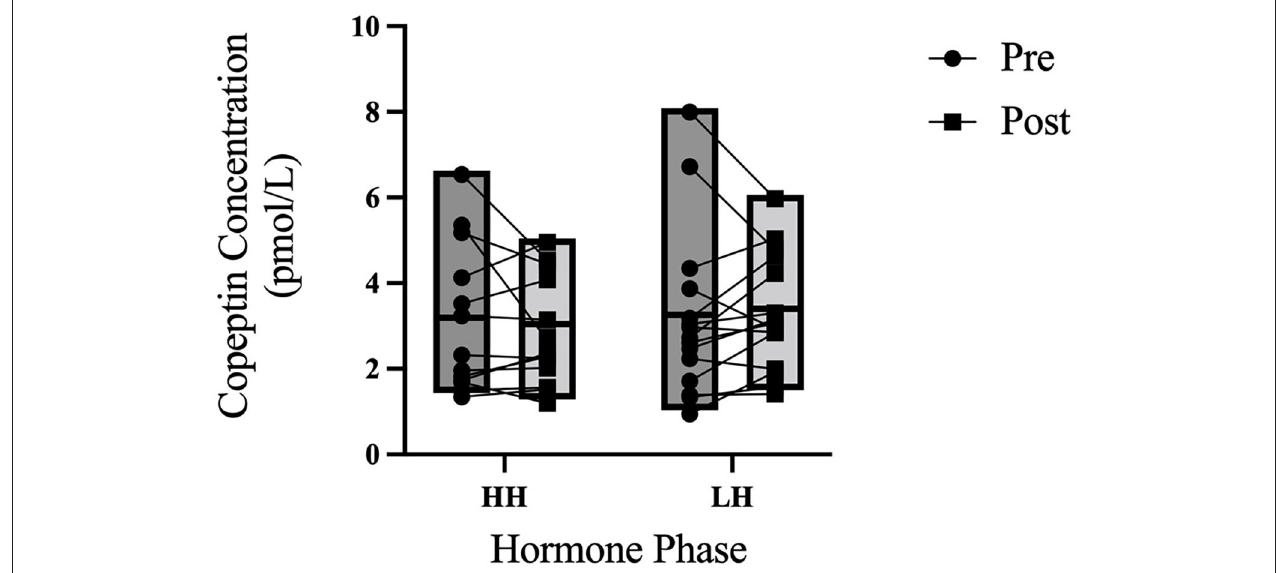
FIGURE 3 | 3-h copeptin responses to an acute water bolus. Individual responses and group summary data is presented in Figure 1 . Copeptin concentration did not differ between phases of OCP use ( P = 0.645) nor from pre- to post-trial ( P = 0.787) nor was there an interaction effect ( P =